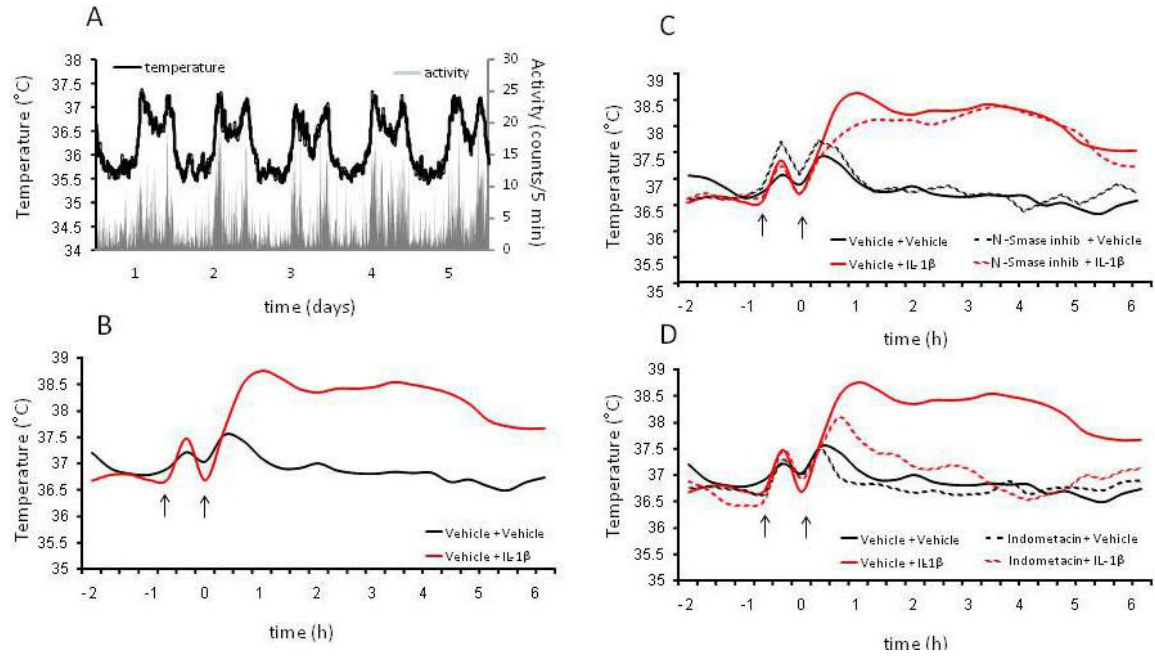
FIGURE 1. Representative profiles of circadian temperature and fever response in mice. (A) Profile CBT (top) and motor activity (bottom) over 5 days of continuous recording; (B) 24-h temperature profile of mice injected with vehicle (saline) and subsequently with the endogenous pyrogen interleukin-1β (IL-1β), showing a stress-dependent modest temperature elevation following vehicle injection and the fever response after lipopolysaccharide (LPS) treatment; (C) N-Smase attenuates the first, fast-acting phase of the fever response to IL-1β; (D) indometacin inhibited the second, long-lasting fever response to